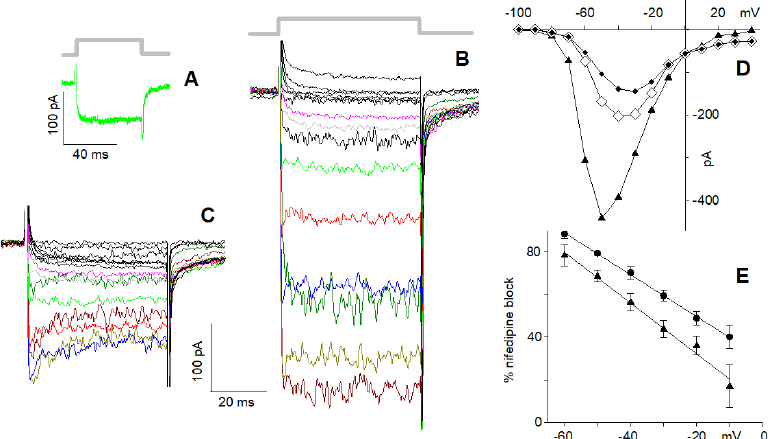
Figure 6. Effect of nifedipine on the L + R2 cation current in 10 nM Ca 2+ . ( A ) Ca 2+ current evoked by a − 20 mV depolarising step (whose timing is indicated by the thick grey line) in 4 mM Ca 2+ in a cell possessing the L and the R2 components. ( B ) Cation currents in 10 nM Ca 2+ elicited in the same cell by the I–V protocol (whose timing is indicated by the thick grey line, which also applies to panel ( C )). ( C ) Effect of 10 µ M nifedipine on the currents in ( B ); time constant of the cation current decay at − 50 mV was 6.1 ms. ( D ) Steady-state I–V relationships obtained from the tracings in ( B ) (triangles) and from the peak and the plateau currents in ( C ) (open and filled diamonds, respectively); ( E ) Average voltage-dependent fractional block operated by nifedipine on the peak (triangles; r = 0.99, slope = − 1.28% per mV, n = 8) and on the plateau (circles; r = 0.99, slope = − 0.97% per mV, n = 8) of the current in ( C ), calculated using the formula: (1 − a / b ) · 100, where a is the peak or the plateau amplitude of current in nifedipine ( C ) at a certain voltage, and b the amplitude (that is always a plateau) in the control at the same voltage (( B ); i.e., 100% block occurs if the current amplitude in nifedipine is zero). Some current traces in ( B , C ) are coloured with the same code of Figure